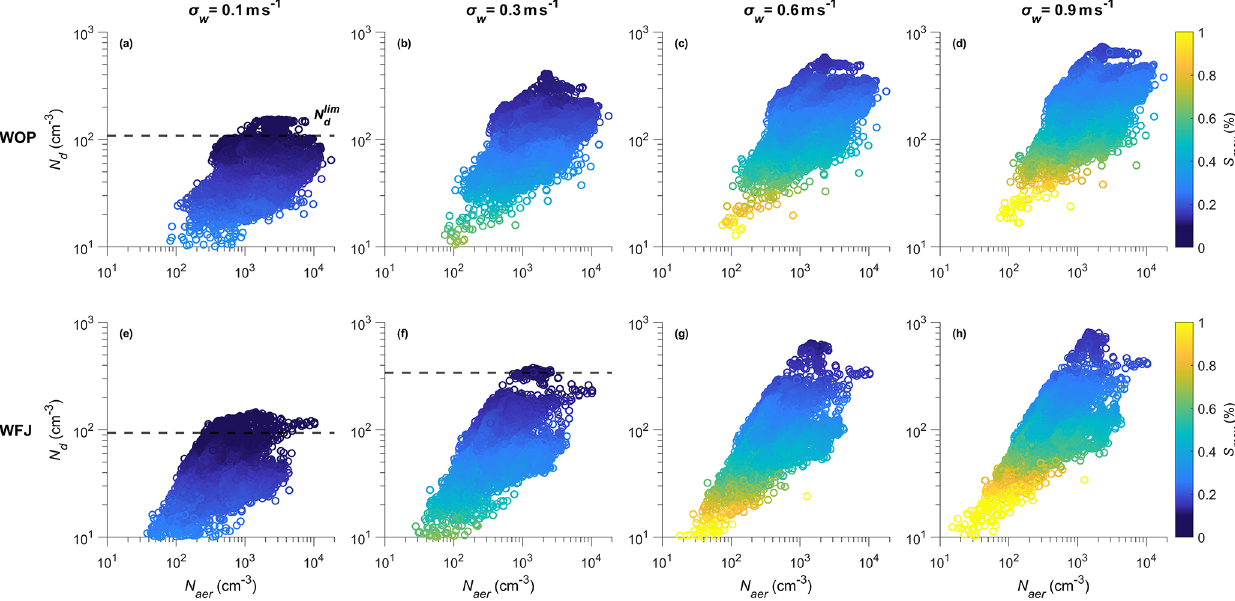
Figure 8. In situ N d (cm − 3 ) vs. N aer (cm − 3 ) for updraft velocities of σ w = 0 . 1ms − 1 in panels (a) and (e) , 0.3ms − 1 in panels (b) and (f) , 0.6ms − 1 in panels (c) and (g) , and 0.9ms − 1 in panels (d) and (h) during the period of interest at WOP (top panels) and WFJ (bottom panels). Data are colored by S max (%).